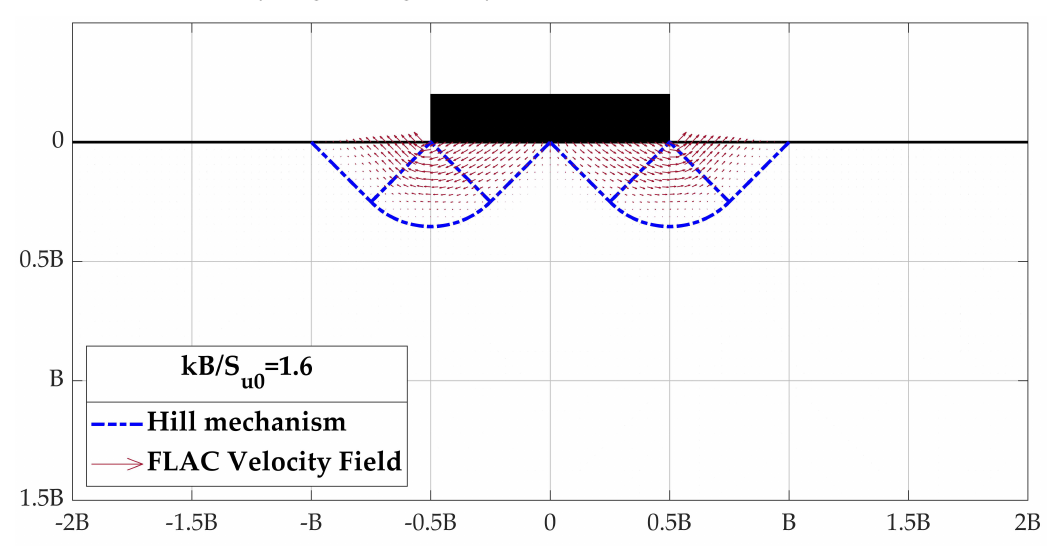
Figure 9. Perfectly smooth footing velocity field at the numerical limit load ( kB / S u 0 =